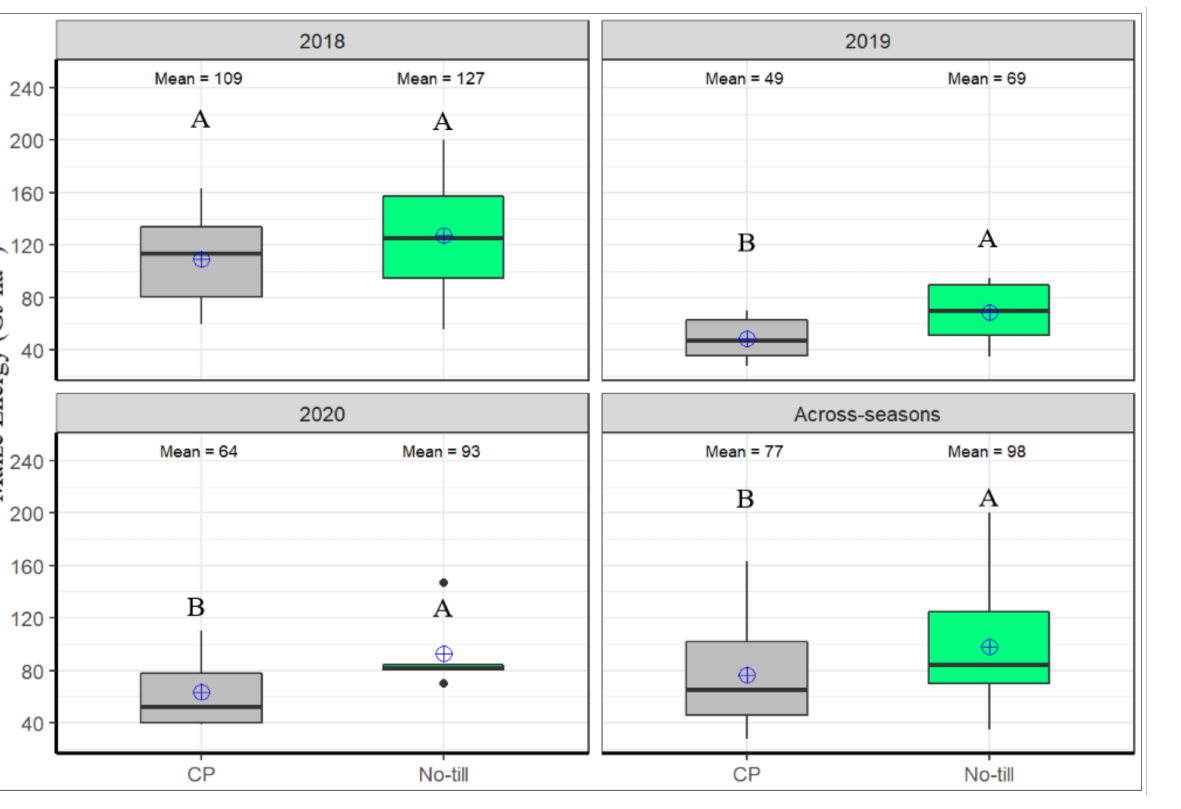
Figure 5. Energy contributions from conventional practice and NT treatments under maize cropping system in 2018, 2019, 2020 and across the growing seasons. Means with different letters (A, B) in the same season are significantly different at p <